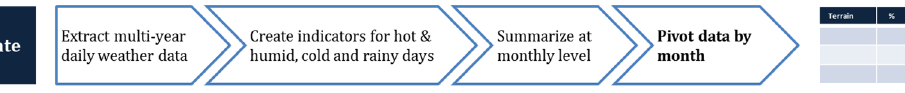
Figure 13. Big data analytics process flow of climate information for thematic TRS.